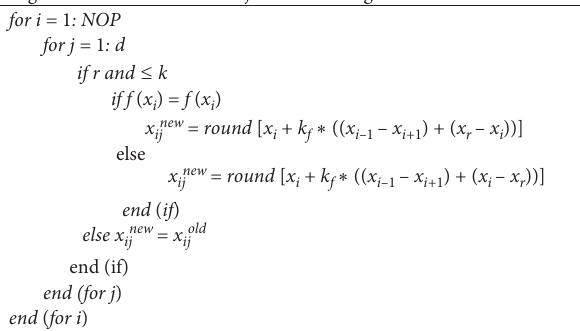
Algorithm 1: Pseudocode for junior GSK stage for i = 1 : NOP